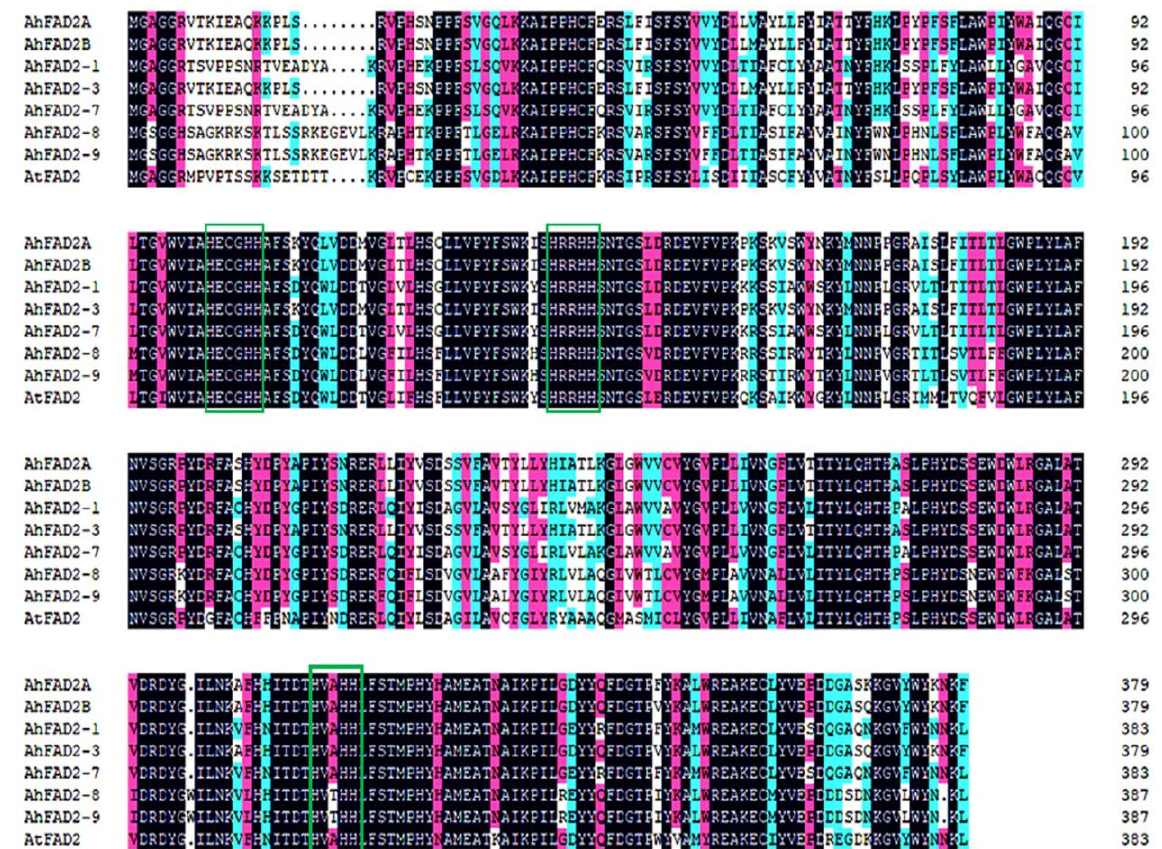
Figure 3. Alignment of FAD2 proteins from different plant species. Black shading indicates conserved amino acids. Green boxes represent H boxes.